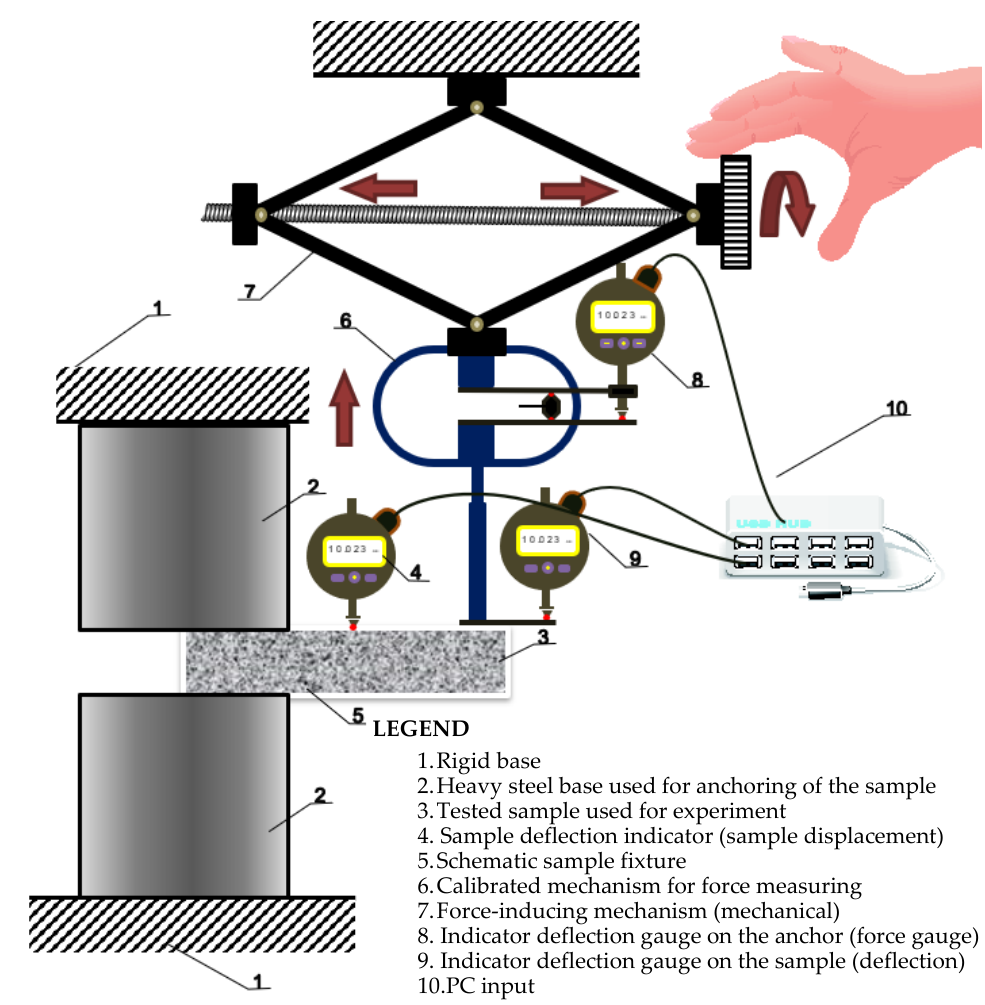
Figure 3. Scheme of experimental measuring setup.